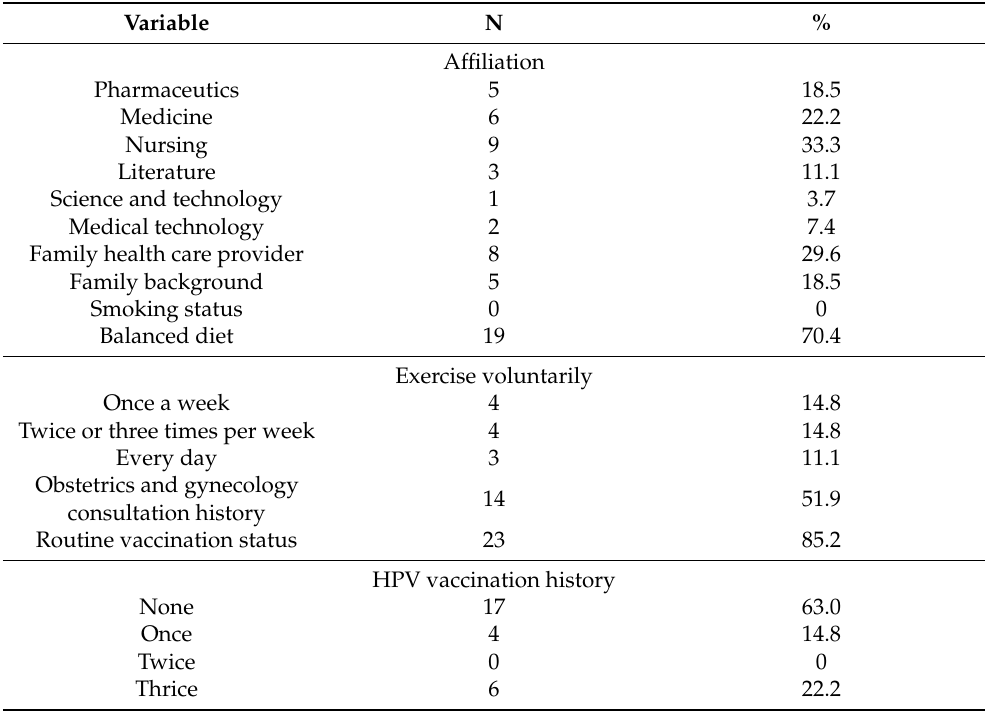
Table 1. Participant